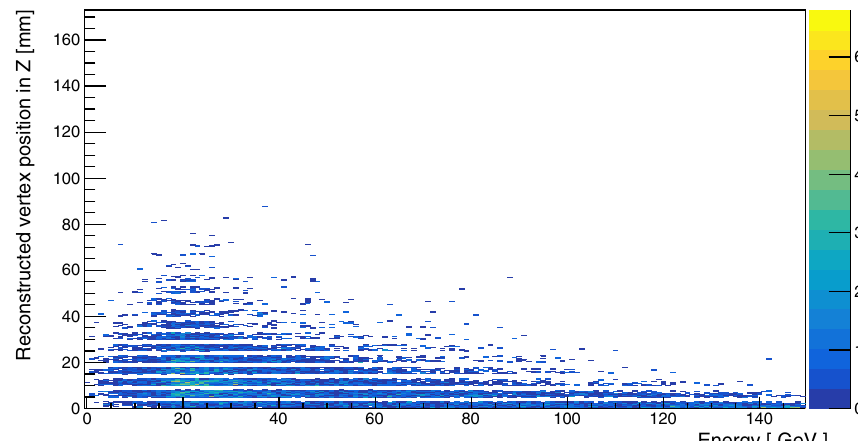
production position at a given energy as a function of